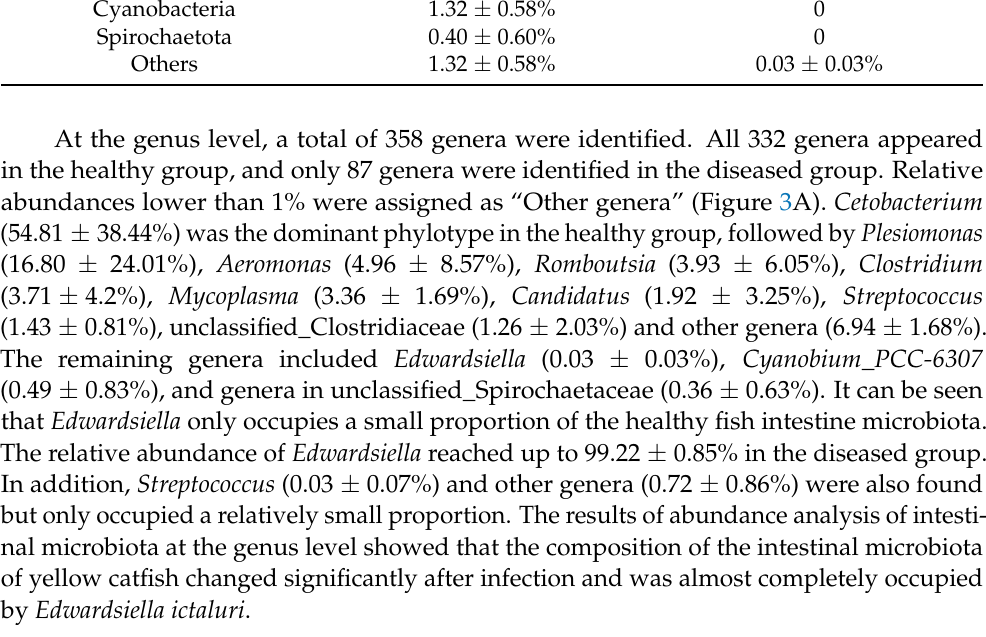
Table 2. Relative abundance of the bacterial phyla in the intestinal microbiota of the two fish groups. Groups Phyla Healthy Diseased Fusobacteriota